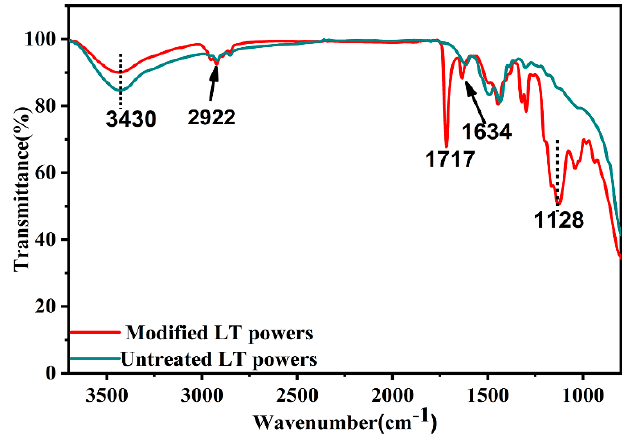
Figure 5. FTIR spectrum of untreated and modified LT powders.